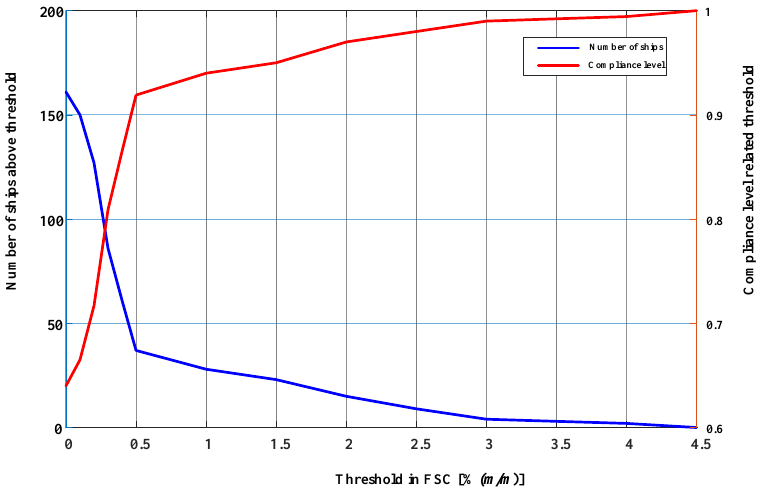
Figure 4. Statistics of 28 ships out of 445 with FSC measured above 0.5% ( m / m ) in Pearl River Delta.